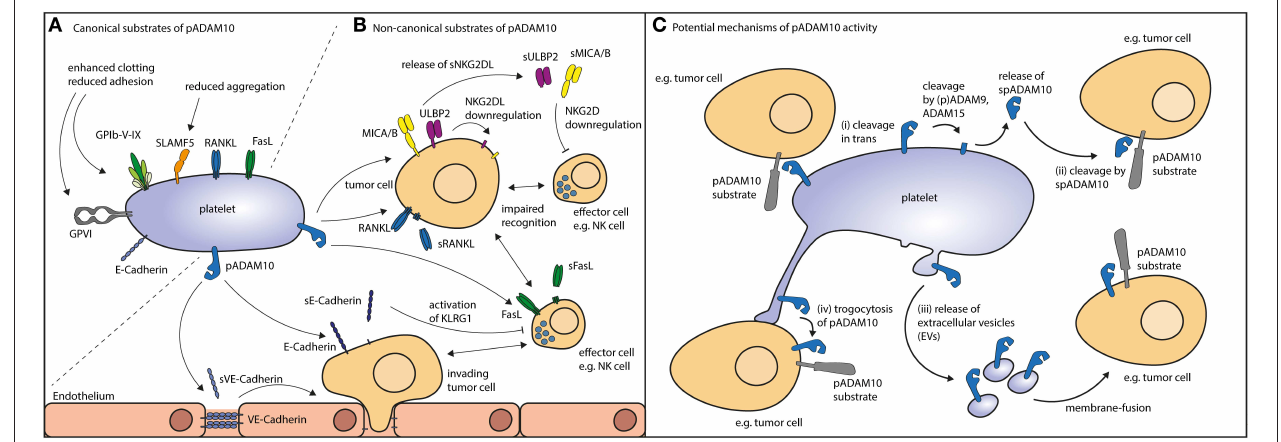
FIGURE 1 | Potential routes of action for pADAM10. (A) Canonical substrates of pADAM10 (see Table 1 ) not only comprise molecular players involved in platelet function as exemplified by glycoproteins and SLAMF5 but also a plethora of immuoregulatory factors alike FasL and RANKL. (B) Non-canonical substrates of pADAM10 on other cells have been suggested to comprise NKG2DL MICA/B, ULBP2, and ectodomain shedding thereof reportedly dampens NK antitumor reactivity. Proteolytic cleavage of E-Cadherin (resulting in soluble E-Cadherin, sE-Cadherin) may inhibit NK effector functions. Cleavage of VE-Cadherin by pADAM10 may interfere with endothelial junctions thereby facilitating tumor invasion. Moreover, immunomodulation may be mediated by pADAM10 shedding of FasL from the surface of immune effector cells or shedding or RANKL e.g., from the surface of tumor cells. (C) Thus, pADAM10 may besides exerting proteolytic activity against substrates within the same membrane ( cis ), mediate (i) cleavage in trans (in the membrane of other cellular compounds). Alternatively, pADAM10 may be released as (ii) soluble form (spADAM10), (iii) contained in extracellular vesicles, or (iv) integrate in the membrane of the substrate-expressing